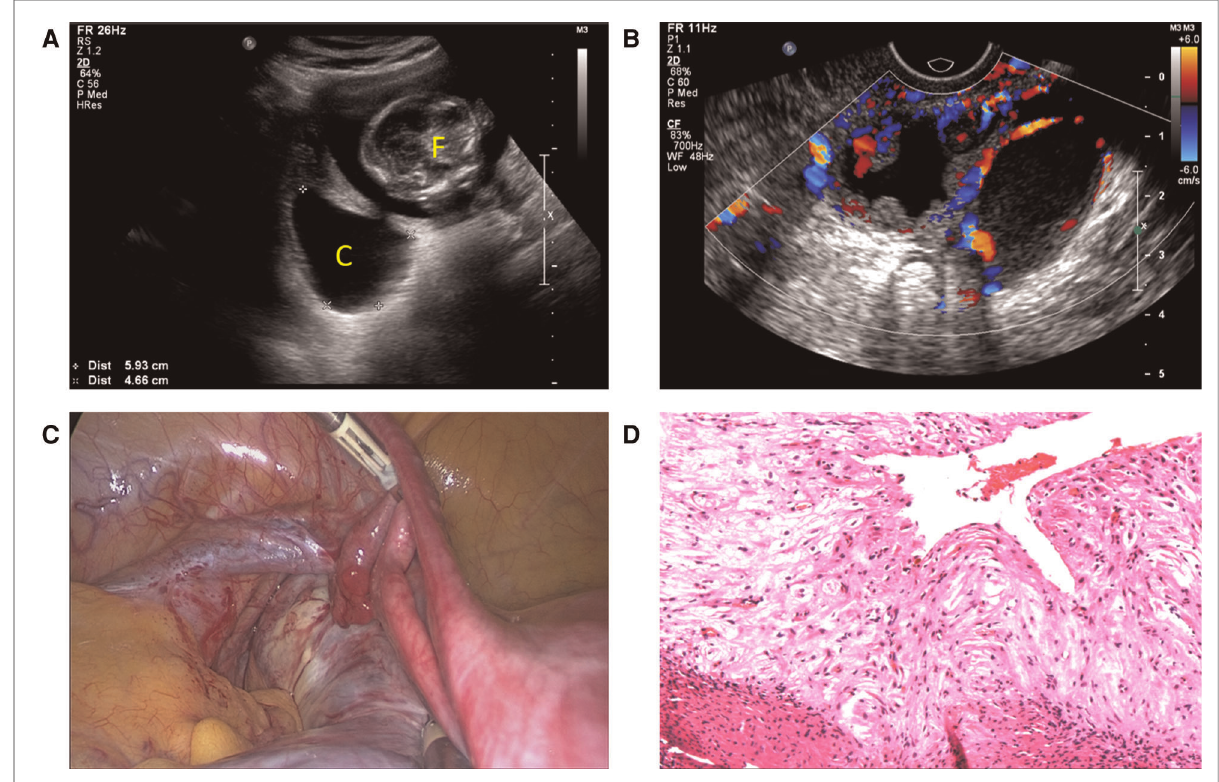
FIGURE 2 ( A ) Ultrasound graph depicting an intrauterine fetus and an adnexal cyst. ( B ) Doppler ultrasound depicting vascularity within capsule wall and papillary projections. ( C ) Laparoscopy showed an 8 cm left ovarian multilocular cyst adhering to the left pelvic wall and mesorectum. ( D ) Pathologic section showed an endometrioma with extensive stromal decidualization (hematoxylin and eosin, ×200). F, fetus; C, cyst